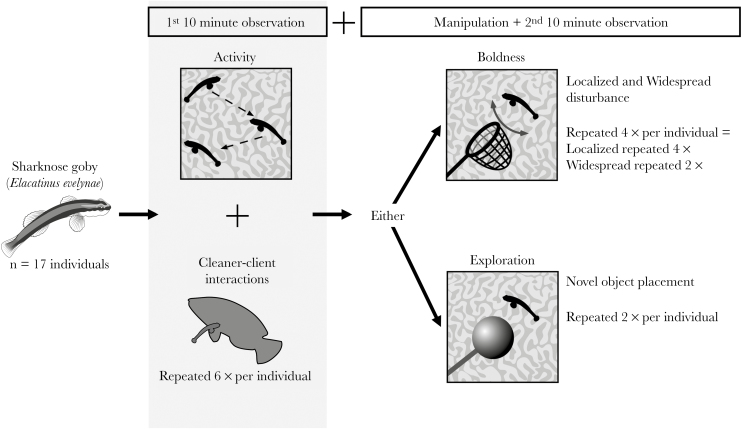
Methods for quantifying sharknose goby (Elacatinus evelynae) personality variation (activity, boldness, and exploration) in situ. Individual gobies were identified from their cleaning stations, and personality assays (boldness vs. exploration) were conducted on separate days using different stimuli. Activity quantification was carried out before each stimuli presentation. Recorded behaviors are listed in text and in Table 1.